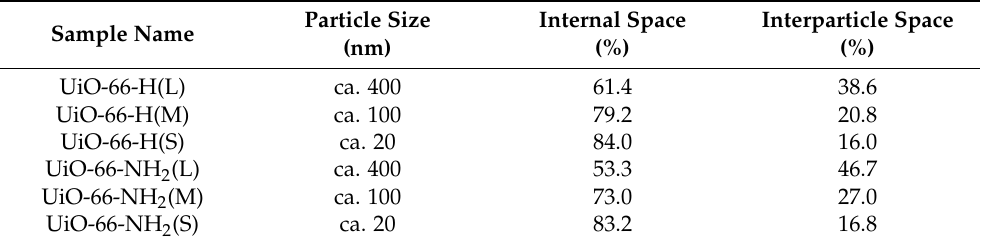
Table 1. Statistical data of UiO-66-H(X) and UiO-66-NH 2 (X) particles on the surface of MOF-coated separators comparing internal space and interparticle space